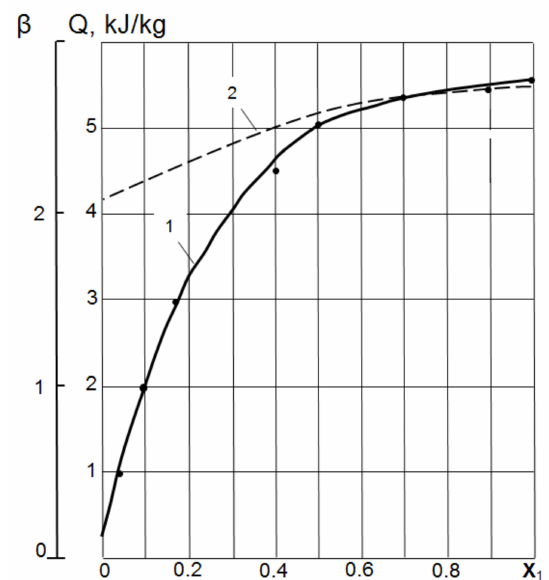
Figure 1. Influence of the MK volume concentration in a mixture of MK and fly ash on the heat of wetting Q and coefficient β : 1—heat of wetting Q in mixtures MK-Ash; 2—coefficient β in the mixtures MK-Ash.